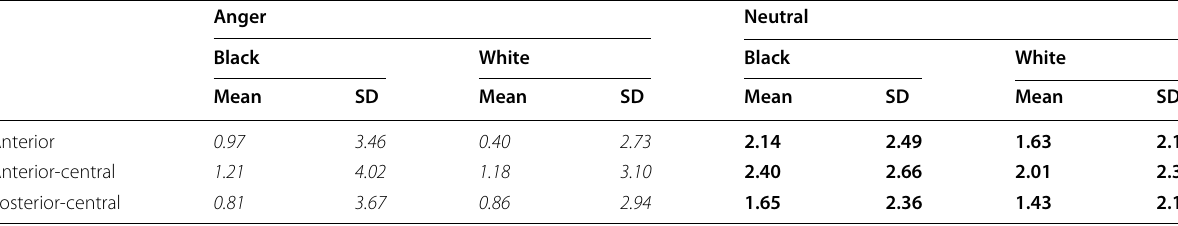
Table 4 Mean P2 amplitude by Emotion and Race